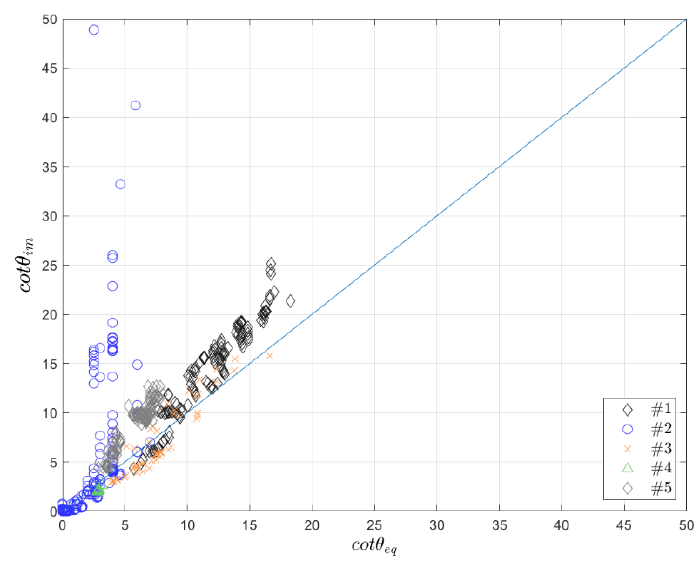
Figure 10 . Imaginary slope (Mase et al., 2013) versus equivalent slope (Altomare et al., 2016).